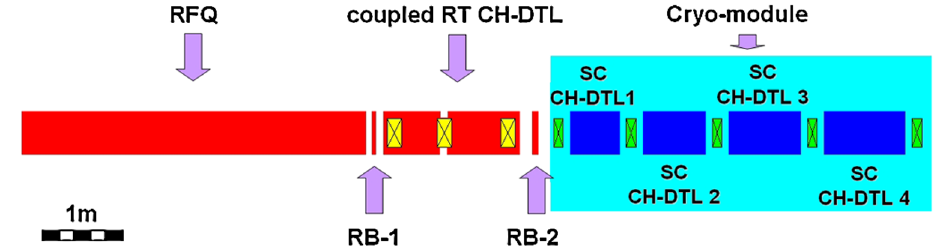
FIG. 10. (Color) The designed layout of the EUROTRANS injector, where triplets and solenoids are marked in yellow and green, respectively.